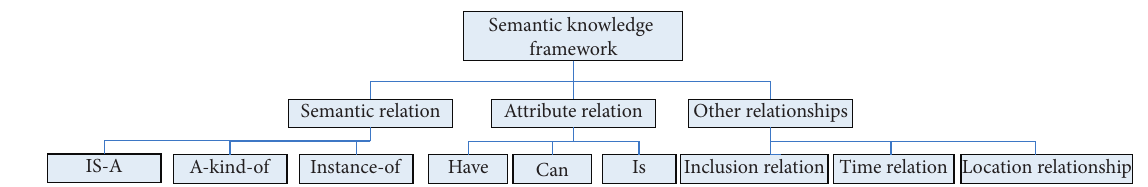
Figure 2: Framework diagram of the semantic knowledge